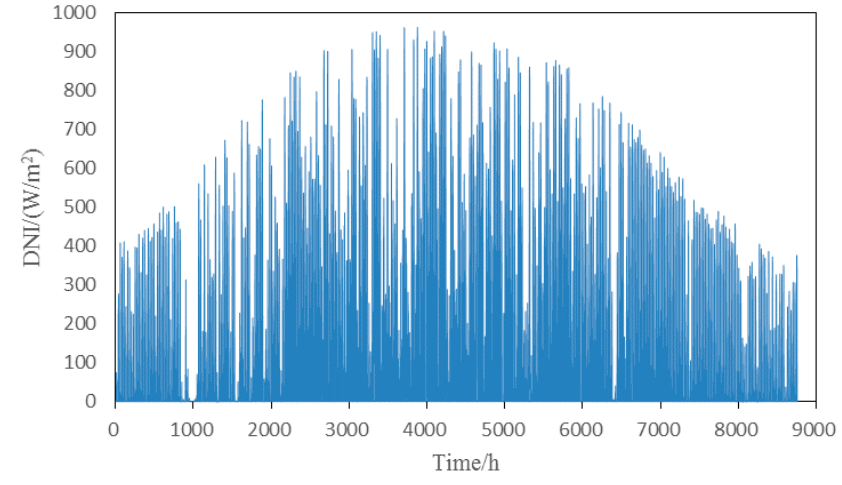
Figure 5. The direct normal irradiance (DNI) data of Dunhuang over a typical year.